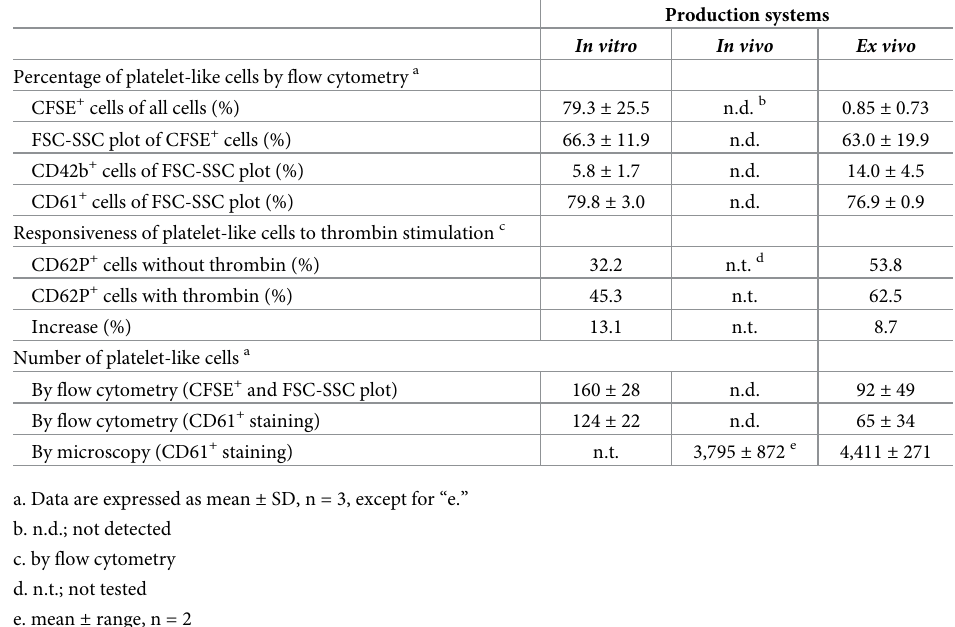
Table 1. The rate of CD42b + and CD61 + cells and the number of platelet-like cells produced by each production system.